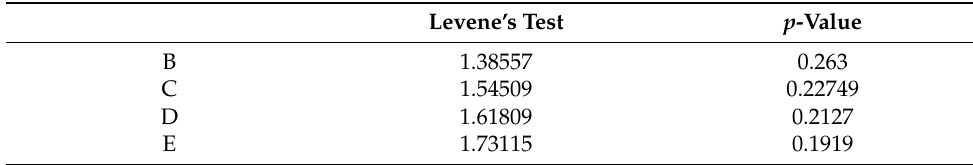
Table 5. Homoscedasticity test for AIC.